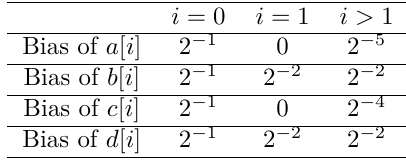
Table 1: Biases of the linear approximation for i -th bit of G function. i = 0 i = 1 i > 1 Bias of a [ i ] 2 − 1 0 2 − 5 Bias of b [ i ] 2 − 1 2 − 2 2 − 2 Bias of c [ i ] 2 − 1 0 2 − 4 Bias of d [ i ] 2 − 1 2 − 2